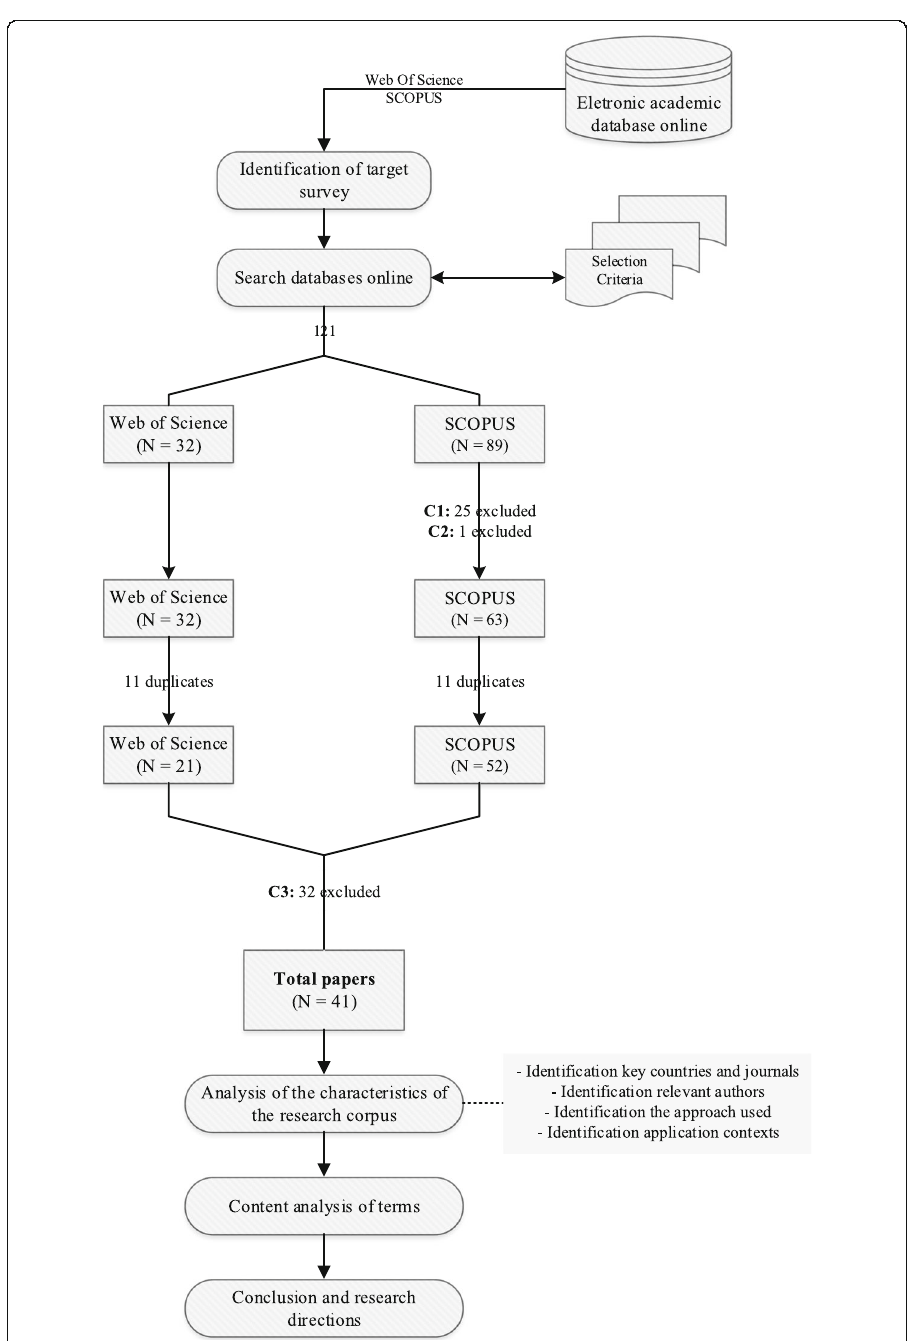
Fig. 1 Systematized research protocol with the inclusion and exclusion criteria of studies on service innovation in SMEs in the research